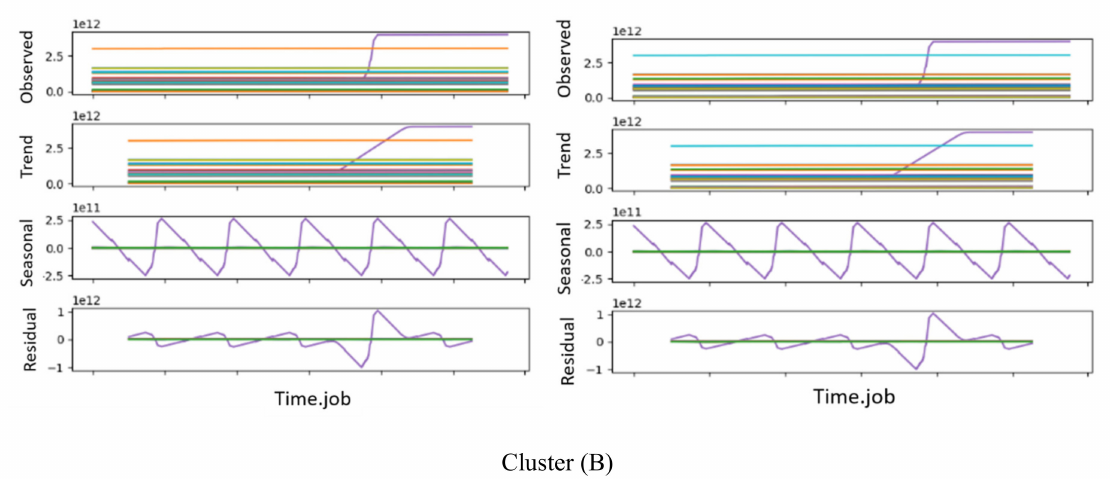
Figure 6. A time series decomposition of jobs from two di ff erent clusters of the KPI interface.bond0.if_octets.rx : the Cluster ( A ) figure shows the time series decomposition of one job from cluster A, whereas the Cluster ( B ) figure shows the time series decomposition of one job from cluster